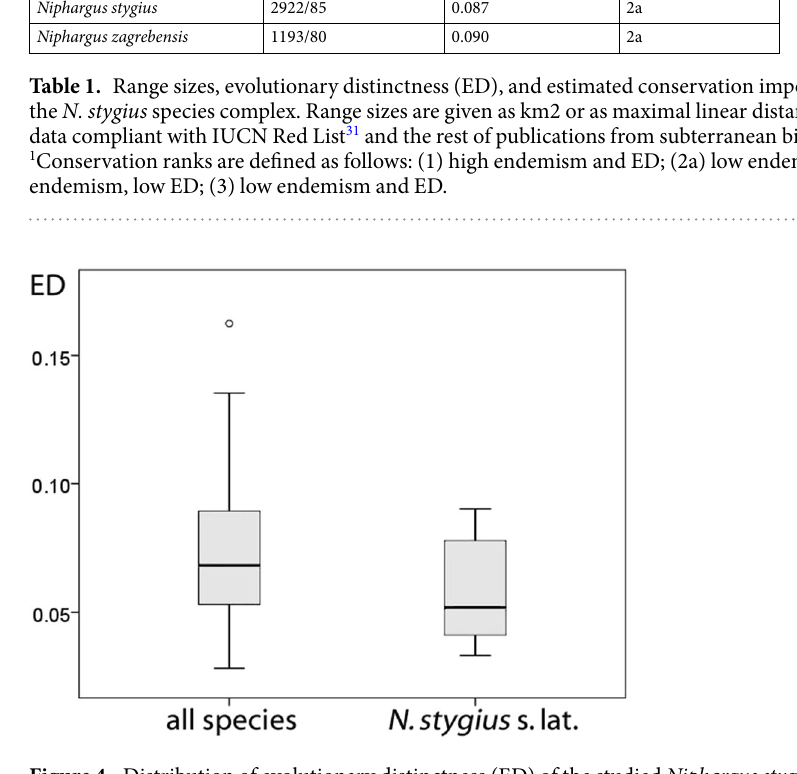
Figure 4. Distribution of evolutionary distinctness (ED) of the studied Niphargus stygius sensu lato compared to the distribution of evolutionary distinctness of other analysed species. Evolutionary distinctness of the studied complex is slightly, but not significantly lower (Mann-Whitney U test, P =